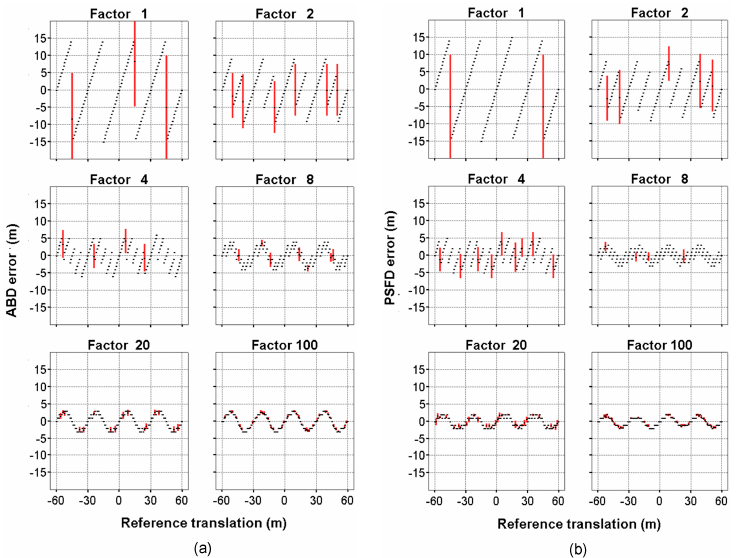
Figure 6. Examples of the behavior of mean errors and standard deviation of errors as a function of the reference translation applied for different sub-image sizes (in pixels). Examples are shown only from the ABD dataset: ( a ) Mean (black) and standard deviation of the errors due to the nine possible band combinations (red) for different sub-image sizes; and ( b ) standard deviations of errors due to spectral and texture differences between sub-images (black), and standard deviations due to the nine possible band combinations (red) for the same sub-image sizes that in ( a ).